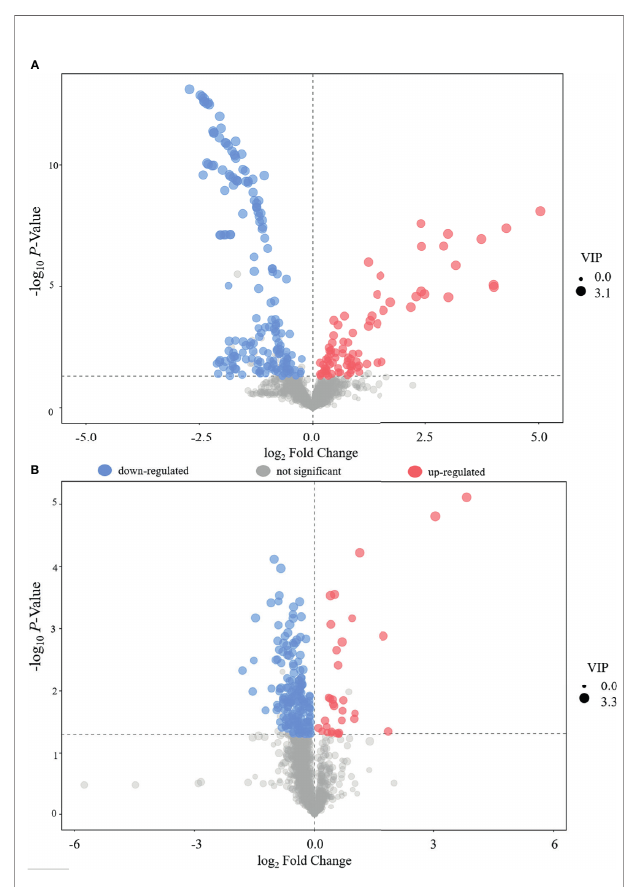
FIGURE 3 | Volcano plot for the differentially expressed metabolites. (A) POS; (B)